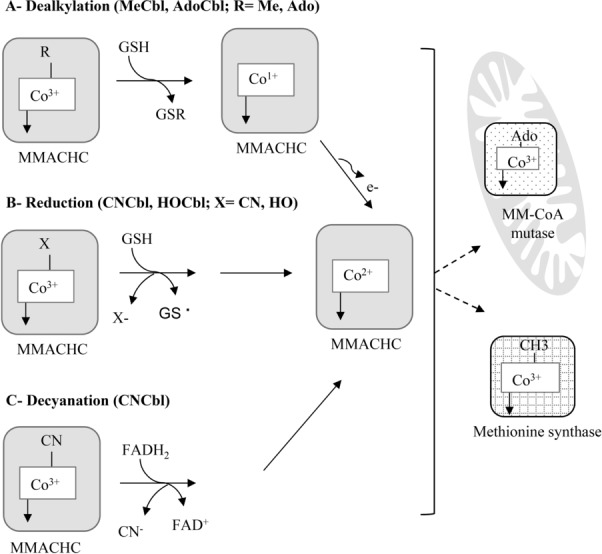
Human MMACHC in the cytosol mediates the removal of the upper ligand in all Cbl forms (MeCbl, AdoCbl, HOCbl, and CNCbl). Dealkylation removes Me or Ado and requires glutathione S-transferase; decyanation of CNCbl requires a flavin reductase system (FAD), and a reduction in the presence of GSH leads to decyanation under anaerobic conditions or removal of HO group. Under all circumstances, a Co+2 intermediate is produced. AdoCbl; adenosylcobalamin, CNCbl; cyanocobalamin, FAD; flavin adenine dinucleotide, HOCbl; hydroxylcobalamin, GSH; glutathione, MeCbl; methylcobalamin, MMACHC; methylmalonic aciduria and homocystinuria type C protein, MM-CoA: methylmalonyl-CoA.